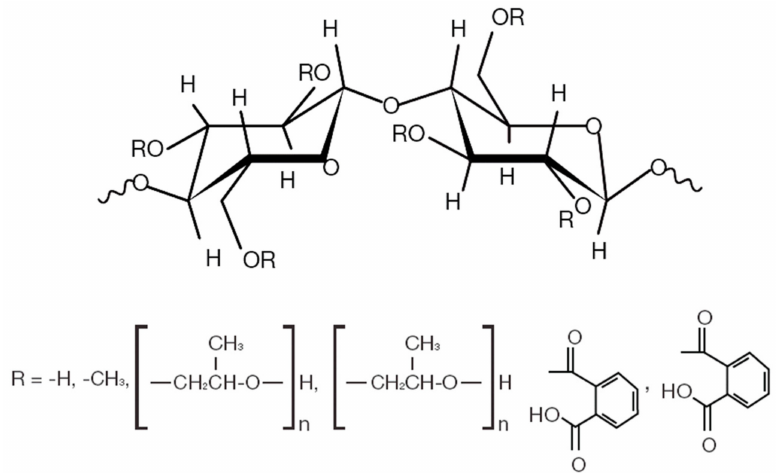
Figure 1. Chemical structure of hydroxypropyl methylcellulose (HPMC) and their substitute